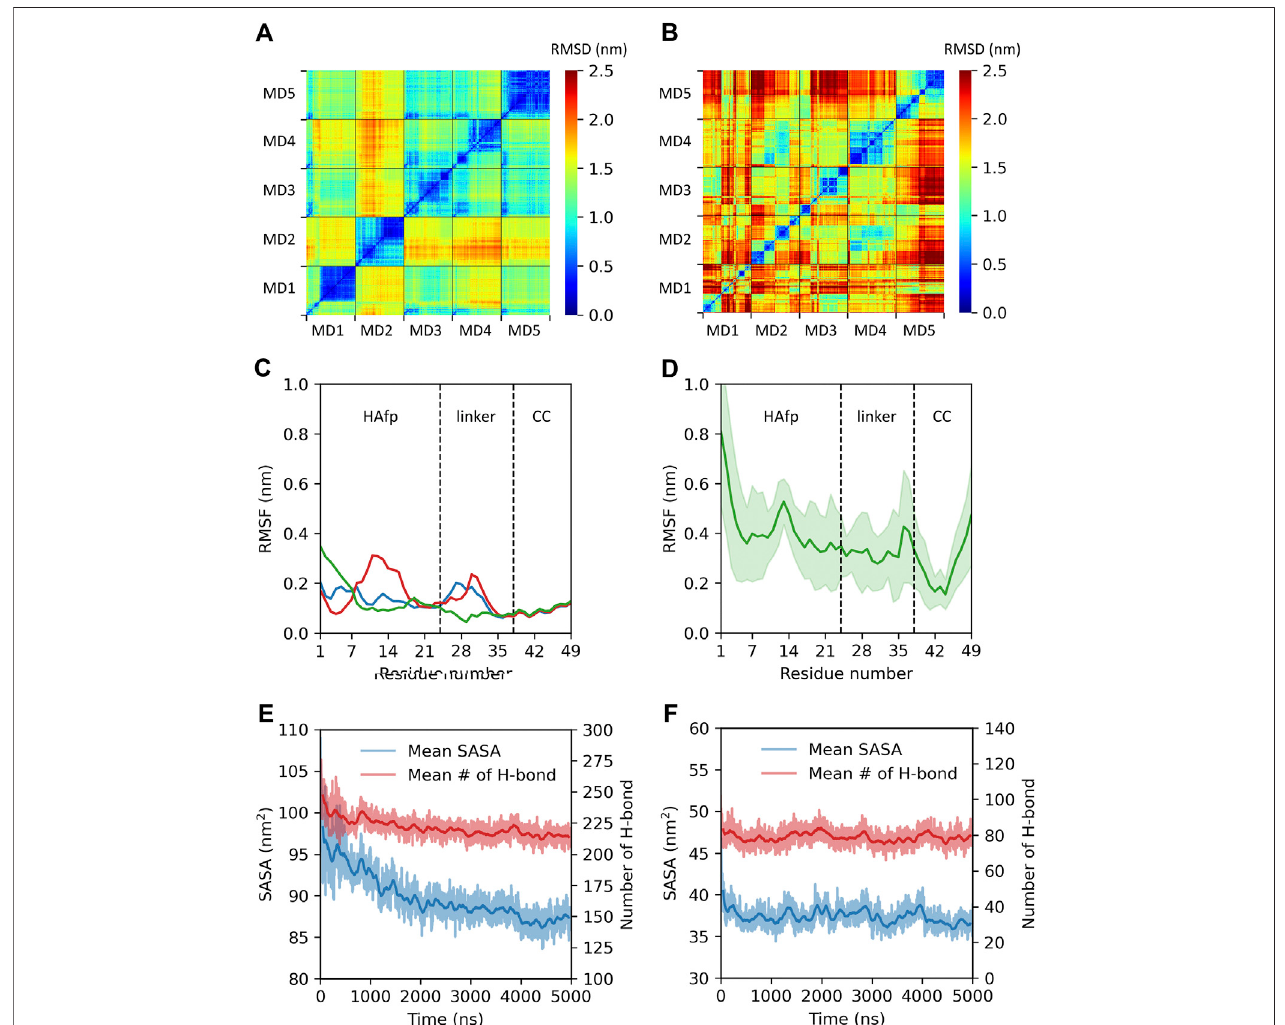
FIGURE 2 | Summary of trimeric and monomeric HAfp dynamics in an aqueous environment. Two-dimensional root mean square deviation (2D cross-RMSD) of HAfps and linkers C α atoms following the alignment of the coiled-coil regions in (A) fi ve trimeric and (B) fi ve monomeric simulations. (C,D) Residue-based C α root mean square fl uctuation(RMSF)pro fi lesforHAfptrimersandmonomers,respectively.CCreferstothecoiled-coil. (E,F) Timeevolutionofmeansolventaccessiblesurfacearea (SASA) and mean number of intermolecular protein-water hydrogen bonds during HAfp trimers and monomers simulations, respectively. Shadows correspond to one standard deviation across 5 MD